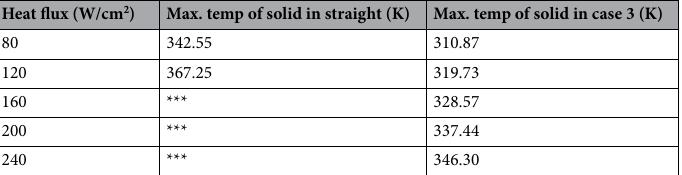
Heat flux (W/cm 2